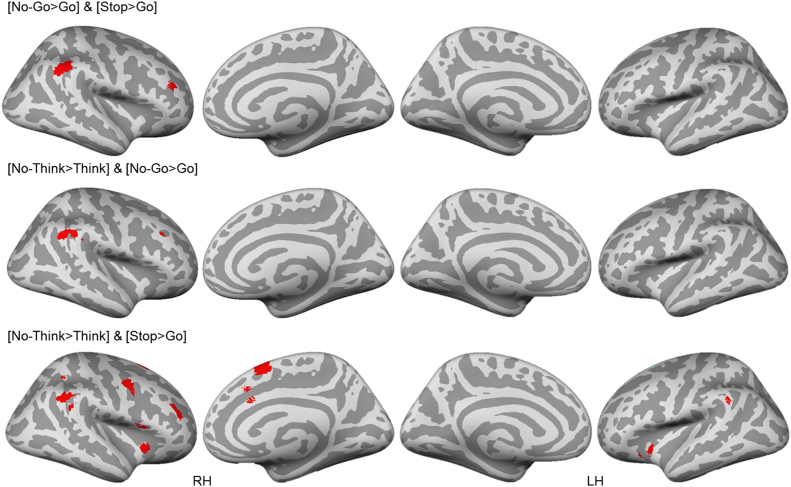
Cross-task conjunction analysis. All clusters are thresholded using cluster-level inference (p<.05, uncorrected p<.001, threshold permutations=1000).